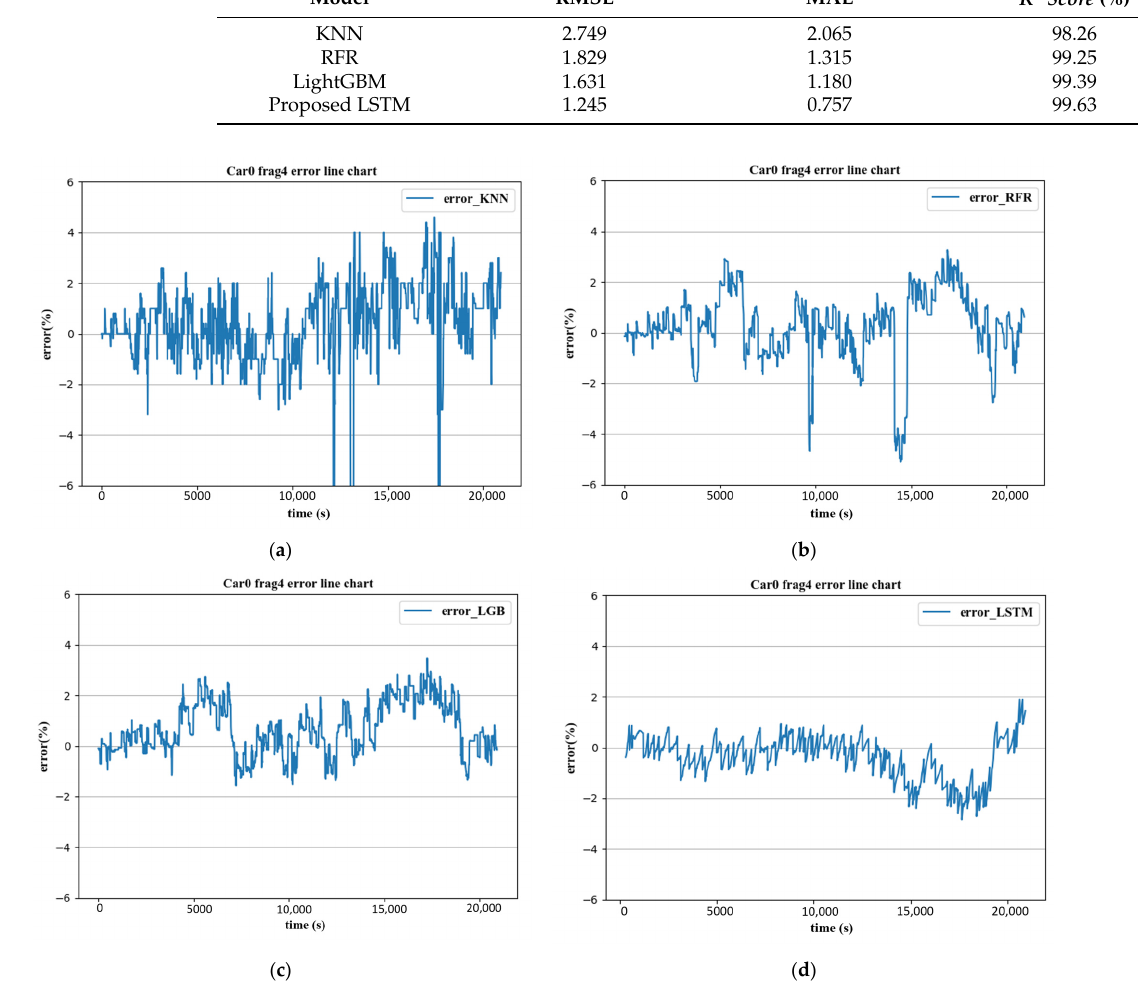
Figure 12. Error comparison of each model. ( a ) The error of the KNN prediction model; ( b ) the error of the RFR prediction model; ( c ) the error of the LightGBM prediction model; ( d ) the error of the proposed LSTM prediction